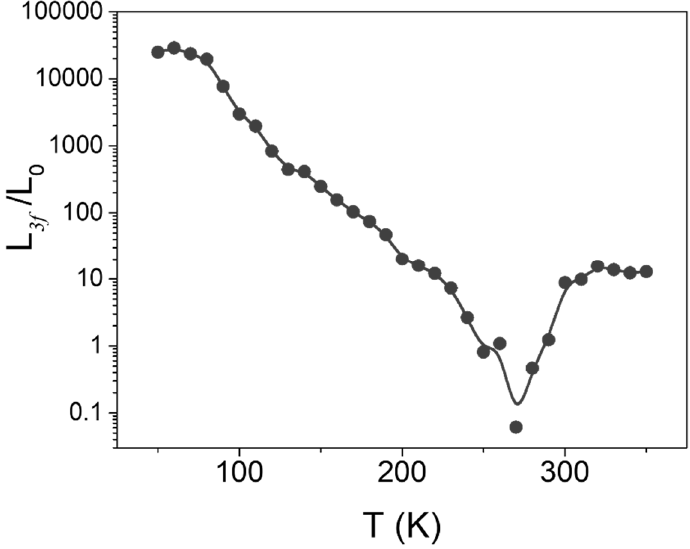
Figure 5. (cid:1838) (cid:2871)(cid:3033) /(cid:1838) (cid:2868) vs. T in temperature range between 50 K and 350 K. Figure 5. L 3 f / L 0 vs. T in temperature range between 50 K and 350 K. Table 1. Whole measurement results from single TaS 3